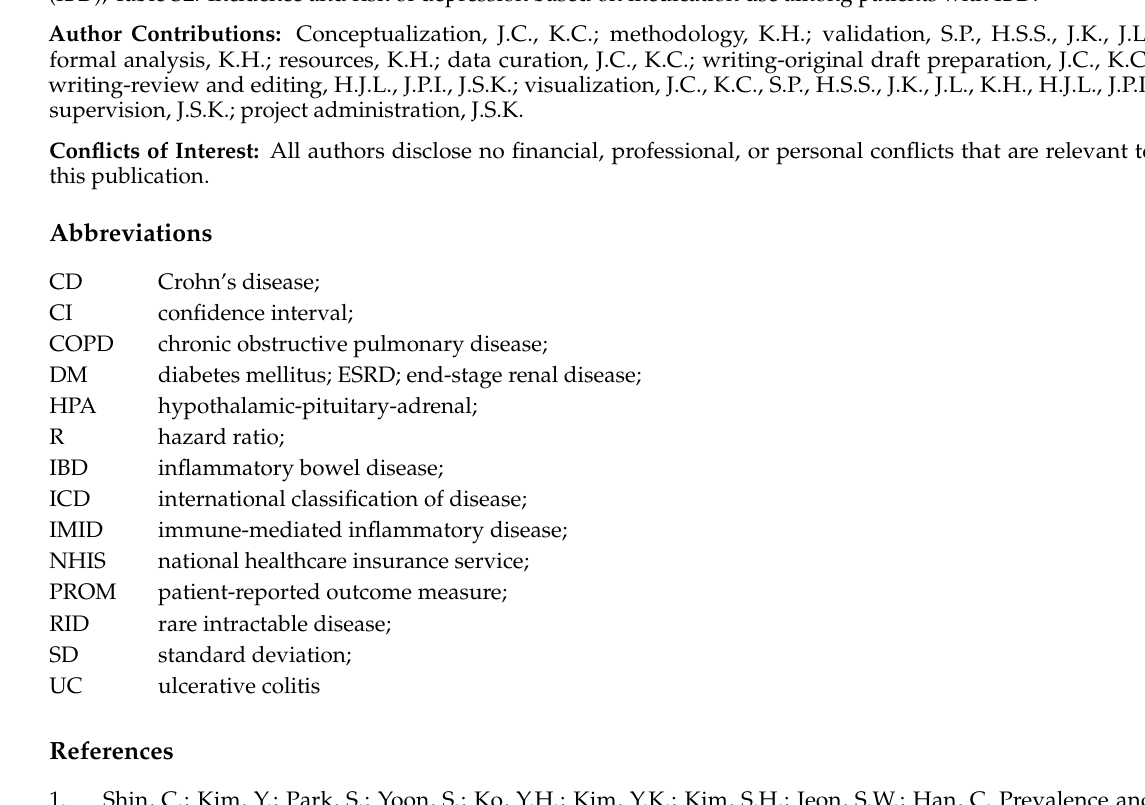
Table S1: Incidence and risk of anxiety based on medication use among patients with inflammatory bowel disease (IBD); Table S2: Incidence and risk of depression based on medication use among patients with IBD. Author Contributions: Conceptualization, J.C., K.C.; methodology, K.H.; validation, S.P., H.S.S., J.K., J.L.; formal analysis, K.H.; resources, K.H.; data curation, J.C., K.C.; writing-original draft preparation, J.C., K.C.; writing-review and editing, H.J.L., J.P.I., J.S.K.; visualization, J.C., K.C., S.P., H.S.S., J.K., J.L., K.H., H.J.L., J.P.I.; supervision, J.S.K.; project administration,